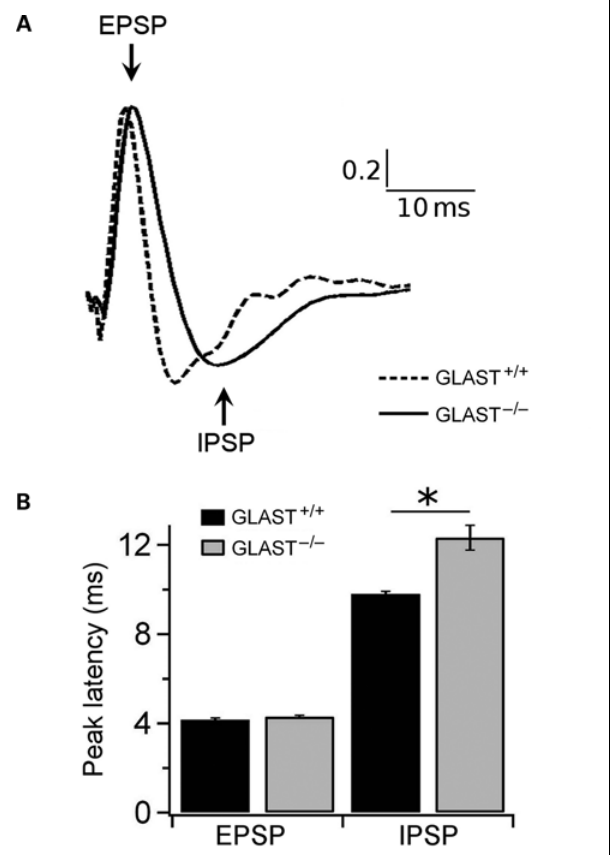
FIGURE 5 | Local field potential recorded in the olfactory bulb under lateral olfactory tract stimulation. (A) Normalized LFP evoked in the granule cell layer under stimulation of the LOT in GLAST + / + (dotted line) and GLAST − / − mice (solid line). (B) The negative component latency of the evoked potential is delayed in GLAST − / − mice (gray bar) compared to the GLAST + / + mice (black bar) indicating enhanced duration of inhibition. * p < 0.0001, t